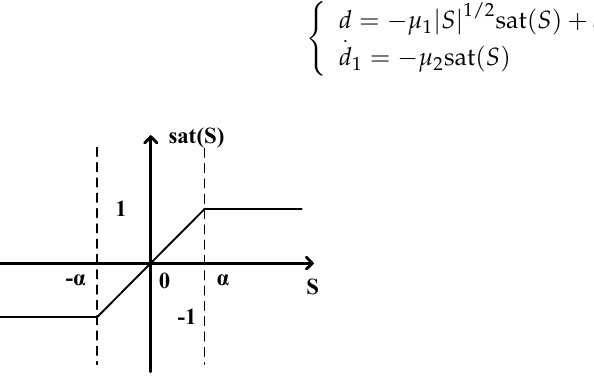
Figure 9. Saturation function 𝑠𝑎𝑡(𝑠) .